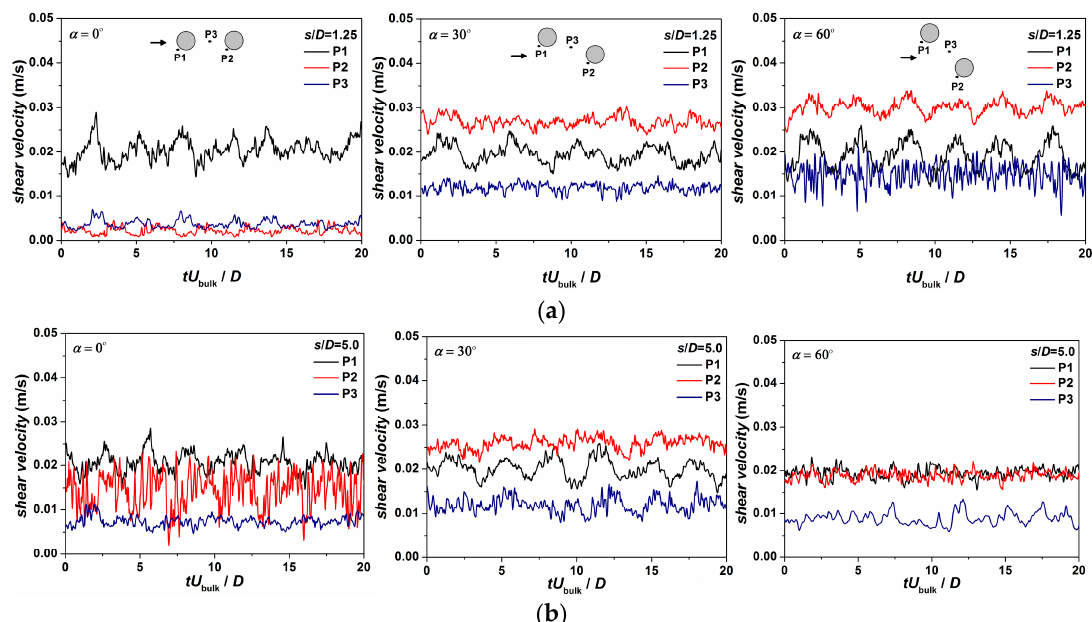
Figure 5. Time series of instantaneous shear velocity ( α = 0 ° ( Left ) ; α = 30 ° ( Middle ); α = 60 ° ( Right )): ( a ) s / D =1.25 and ( b ) s / D =5.0.